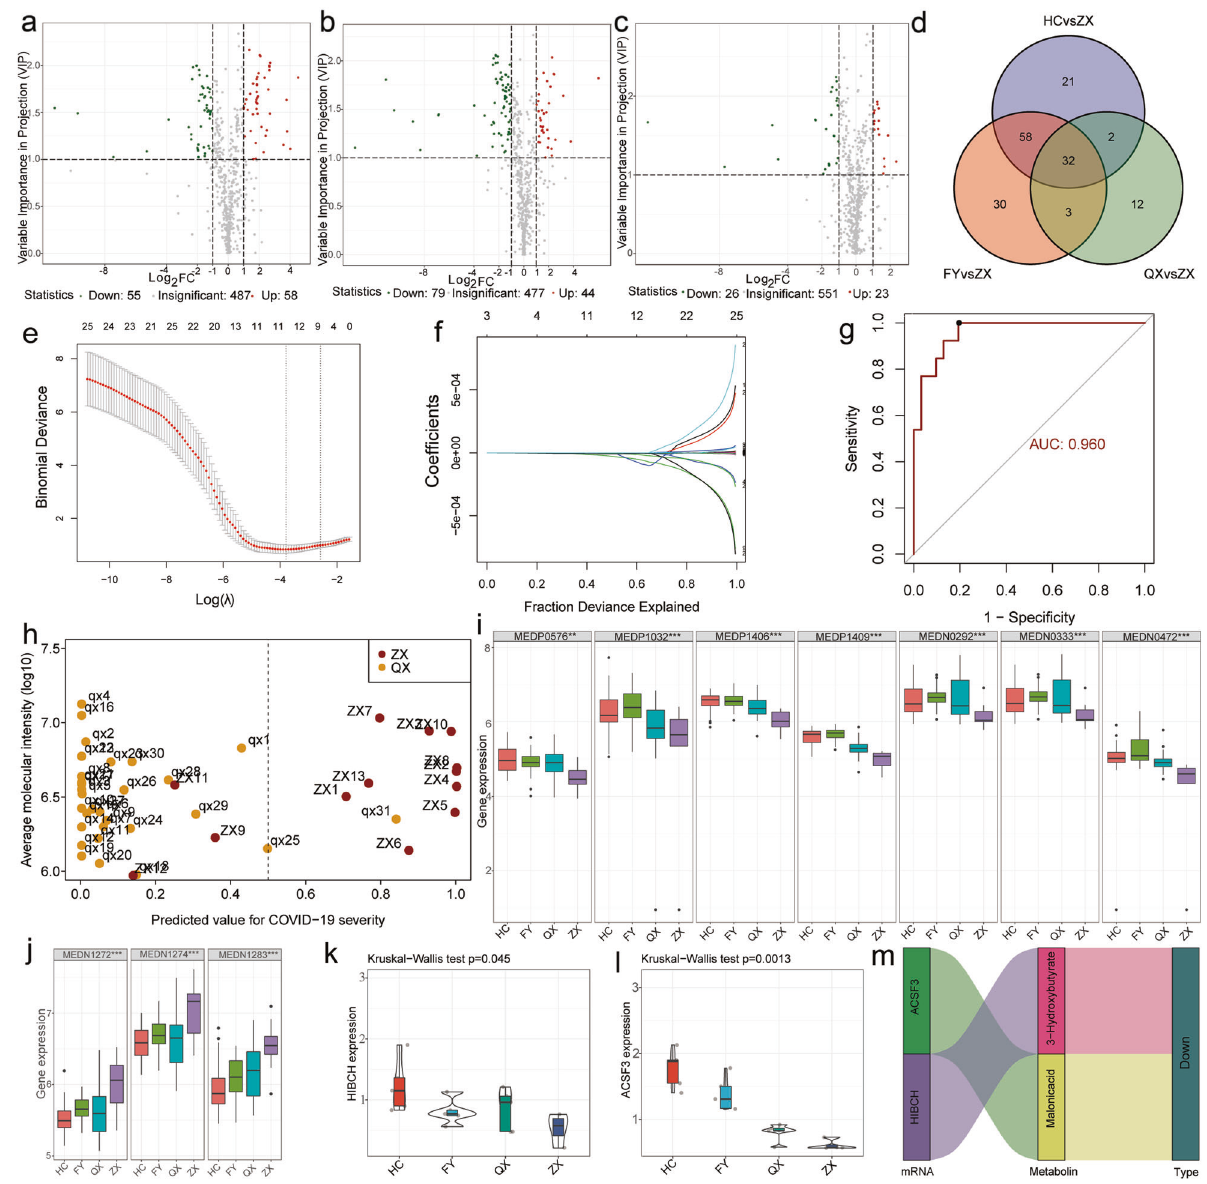
Fig. 1 Novel potential metabolic biomarker panel for early detection of severe COVID-19. HC, healthy controls. FY, community-acquired pneumonia. QX, mild COVID-19 patients. ZX, severe COVID-19 patients. Differences in metabolites between severe COVID-19 patients and healthy controls ( a ), CAP ( b ), and mild COVID-19 ( c ) are illustrated by volcano plots. d Venn diagram analysis showing shared differentially expressed metabolites in the severe COVID-19 group compared with the other three groups. e , f Metabolites presenting speci fi city in severe COVID-19 patients screened by LASSO regression. g Receiver operating characteristics analysis demonstrating the diagnostic value of this diagnostic panel in severe COVID-19 patients and mild COVID-19 patients. h Performance of this diagnostic model in differentiating between severe COVID-19 patients and mild COVID-19 patients. i , j Expression levels of the ten differential metabolic markers in the four groups. k Expression of HIBCH in the four groups. l Expression of ACSF3 in the four groups. m Potential regulatory relationship between HIBCH